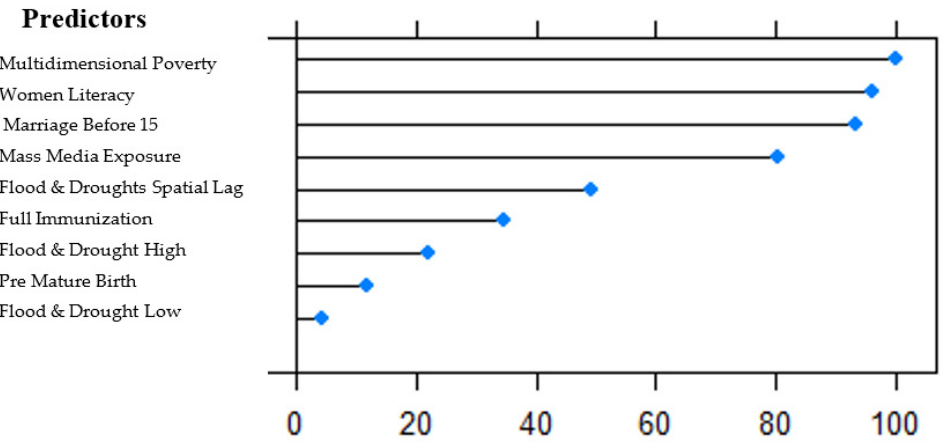
Figure 7. Variable importance as identified by XGBoost algorithm for predictions (the x-axis is in %; the y-axis lists the variables).